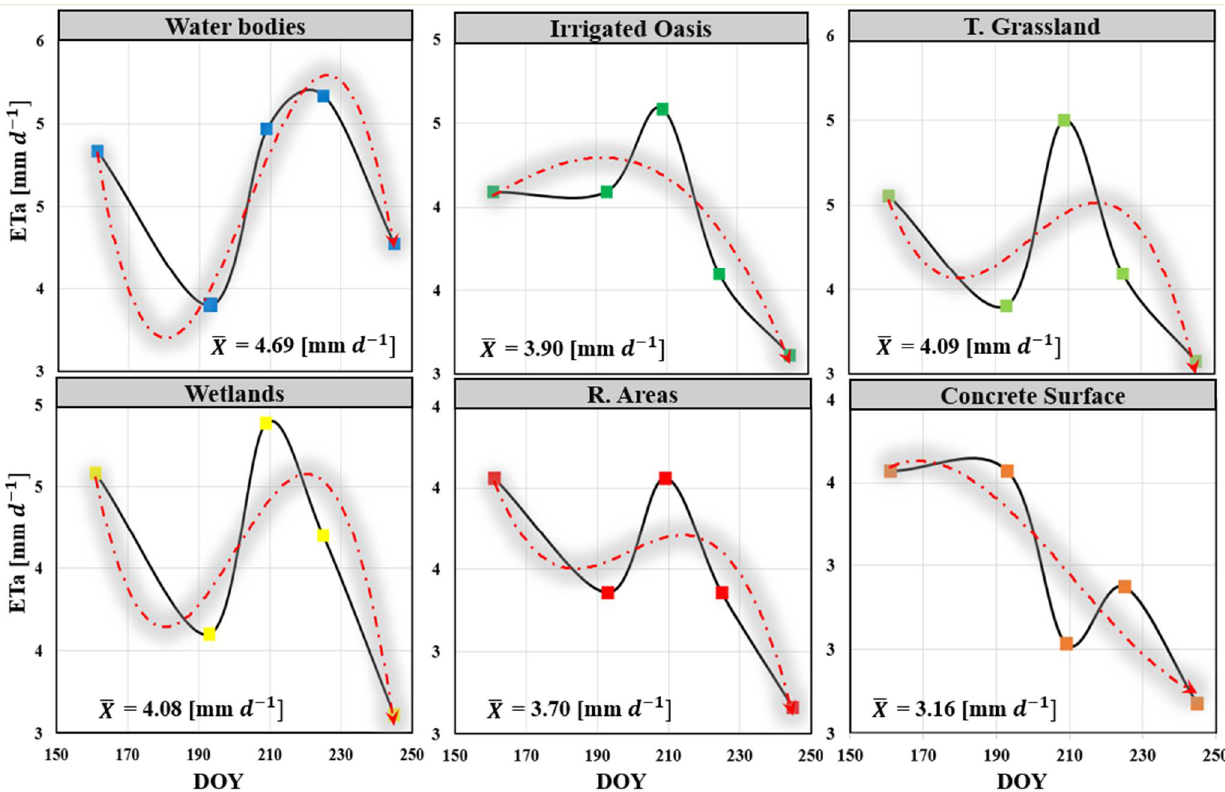
Figure 11. Trends of daily ETa across every single land-use type. (The red dotted line indicates the 3rd order polynomial trend).